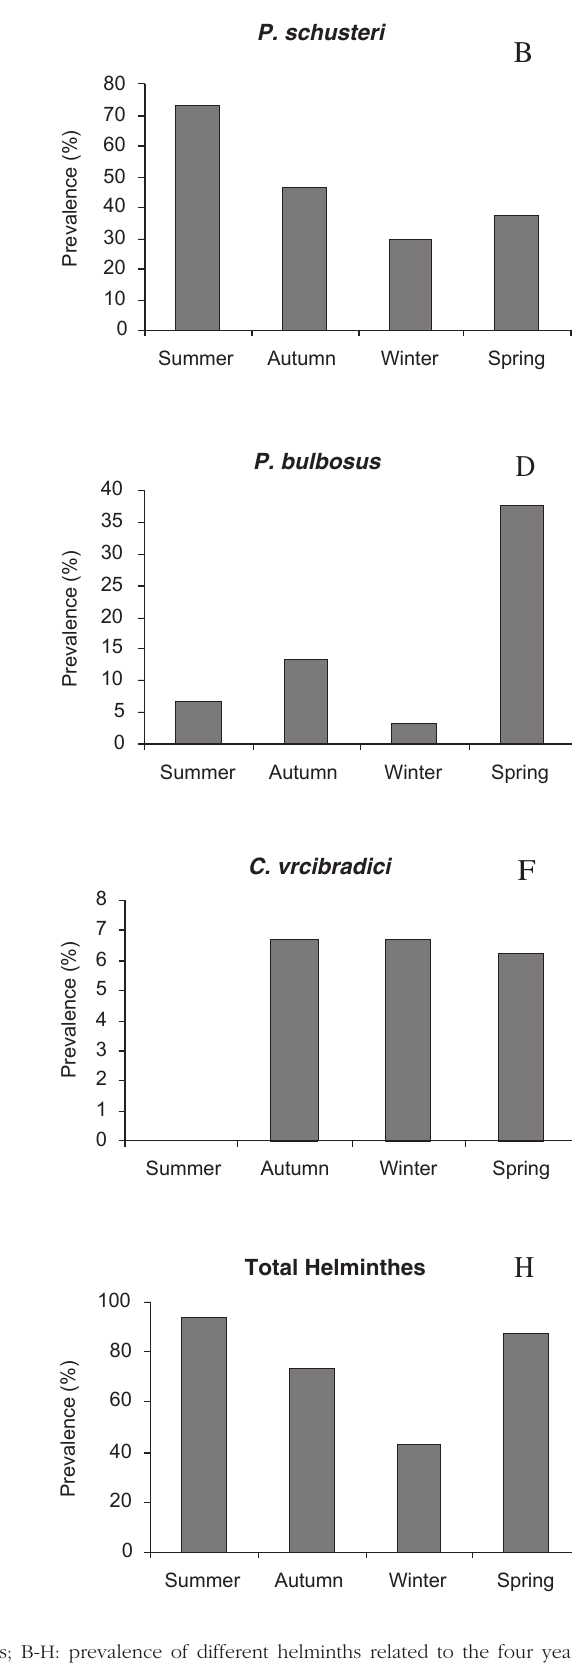
Fig. 1. – A: seasonal changes in mean infracommunity species richness; B-H: prevalence of different helminths related to the four year